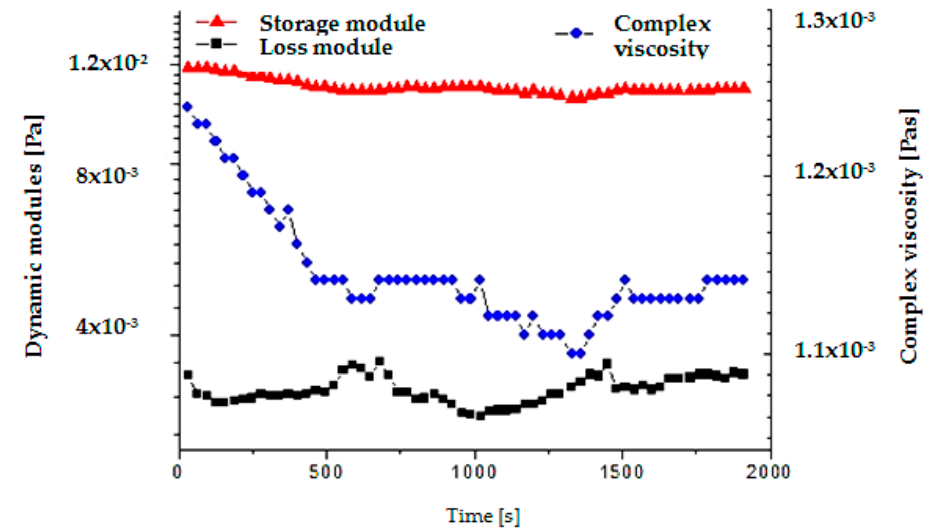
Figure 7. Storage module, loss module and complex viscosity for EM_1b after rigorous stirring.